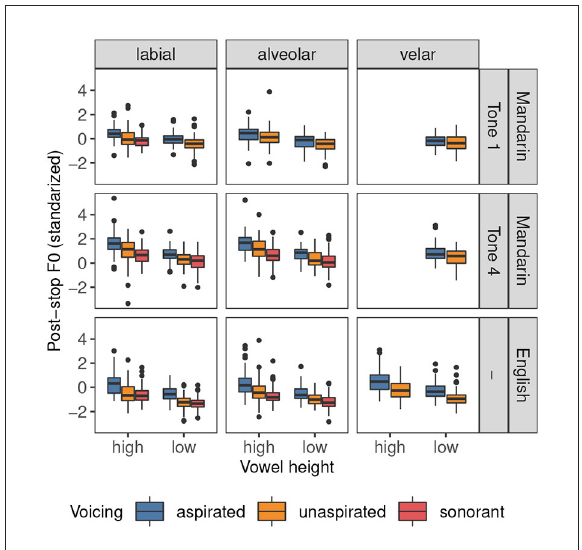
FIGURE1 Standardized post-stop F0 values, normed by speaker, as a function of place of articulation, language/tone, vowel height, and phonological